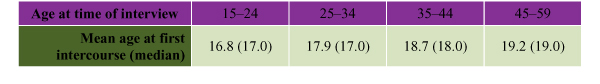
Age at First Intercourse by Age Group. Source: Canadian Community Health Survey, Statistics Canada, 2000–2001